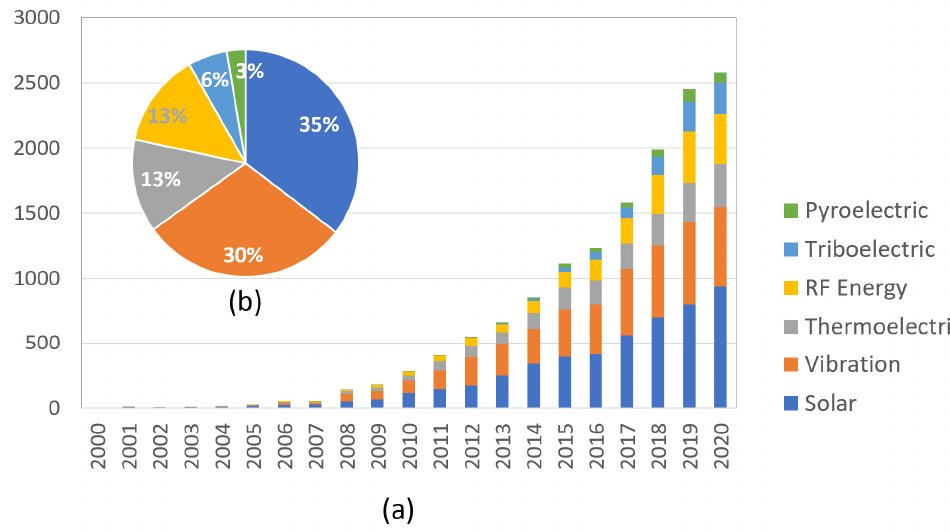
Figure 1. Development of publications on energy harvesting for industrial applications classified by dominant subfields since the year 2000: ( a ) number, ( b ) distribution on the different subfields. Various valuable reviews have given insights into industrial wireless networks in the context of Industry 4.0 [6]. Some of them deal with energy harvesting technologies to supply wireless sensor nodes by using a certain type of ambient sources such as vi- bration [7], sound [8], and electromagnetic [9] and carbon nanocomposite-based energy generators [10]. Another type of review focused on the study of different energy harvesting sources to achieve self-power wireless sensor nodes for specific industrial applications, such as in machine condition monitoring [11], railway applications [12], and aeronautical industries